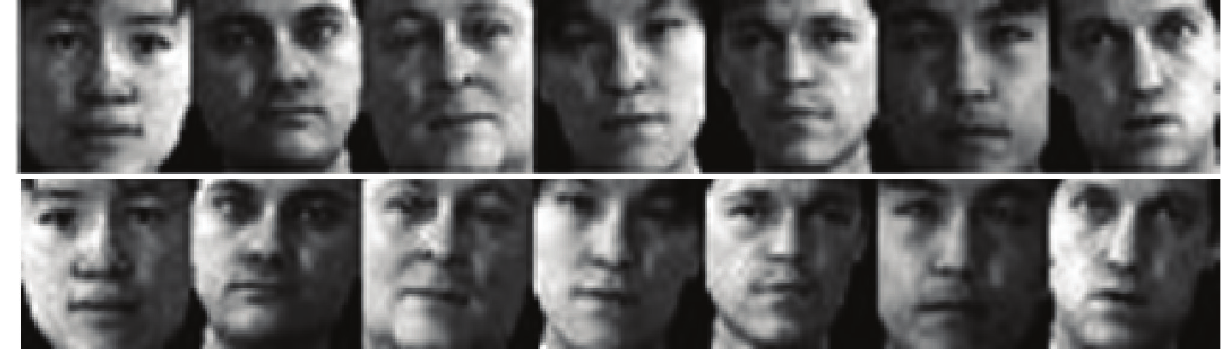
Figure 1: Some original training samples from the PIE database and the mirror faces generated from the original training samples. The first row shows the original training samples. The second row shows the mirror faces generated from the original training samples.